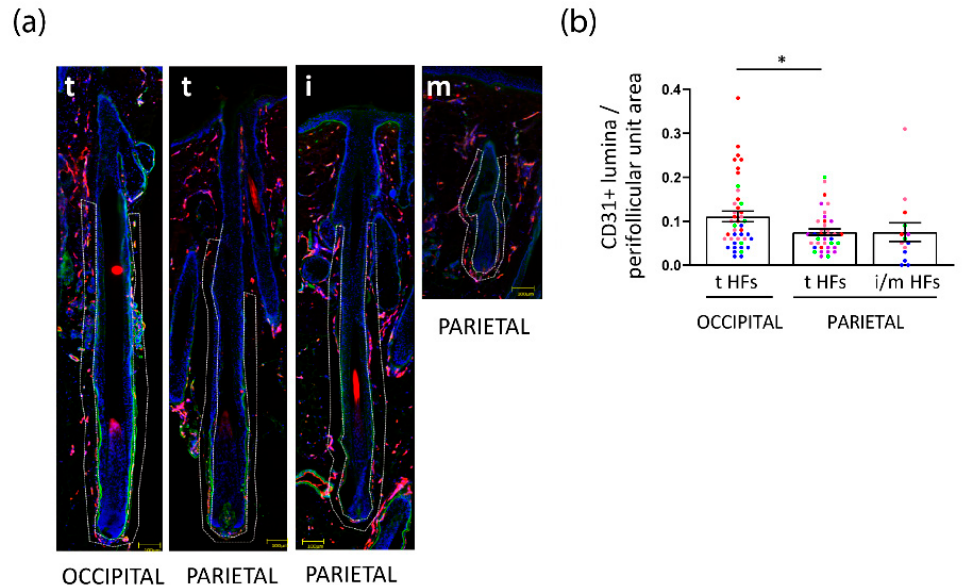
Figure 5. Perifollicular vascularization is reduced in FPHL parietal scalp, yet not specifically in intermediate HFs. ( a ) Representative images of in situ Cluster of Differentiation 31 (CD31)/Collagen IV (ColIV) double immunofluorescence staining of a terminal hair follicle from FPHL occipital scalp skin, and of a terminal, intermediate, and miniaturized hair follicle from FPHL parietal scalp skin. Dotted lines highlight the perifollicular areas. ( b ) The number of CD31+ lumina was counted in the perifollicular area of terminal and intermediate/miniaturized FPHL hair follicles mean ± SEM n = 14–43 HF from n = 4–5 FPHL donors (1: red, 2: green, 3: blue, 4: purple, 5: pink). Graph Pad Prism 9. Kruskal–Wallis test p = 0.0264, Dunn’s multiple comparison n.s.; multiple Mann–Whitney test with Benjamini and